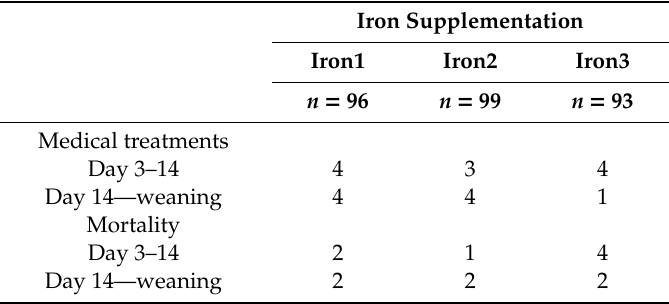
Table 5. Incidence of medical treatments and mortality of organically reared piglets receiving iron supplementation by subcutaneous injection on their third day of life only (Iron1), on day 3 and 14 (Iron2) and on day 3, 14 and 21